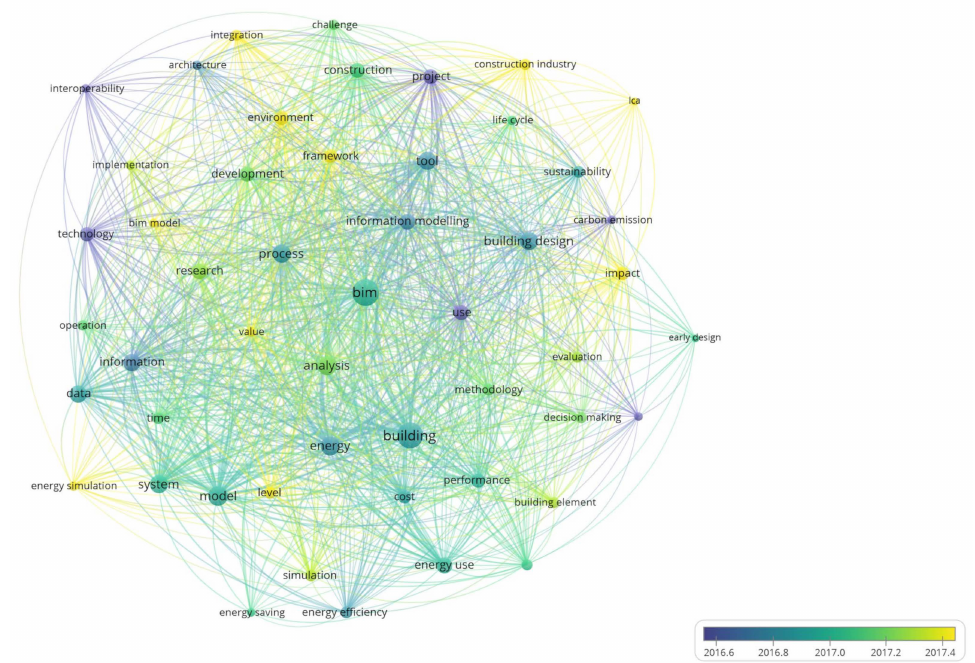
Figure 3. The most common keywords for BIM and building energy